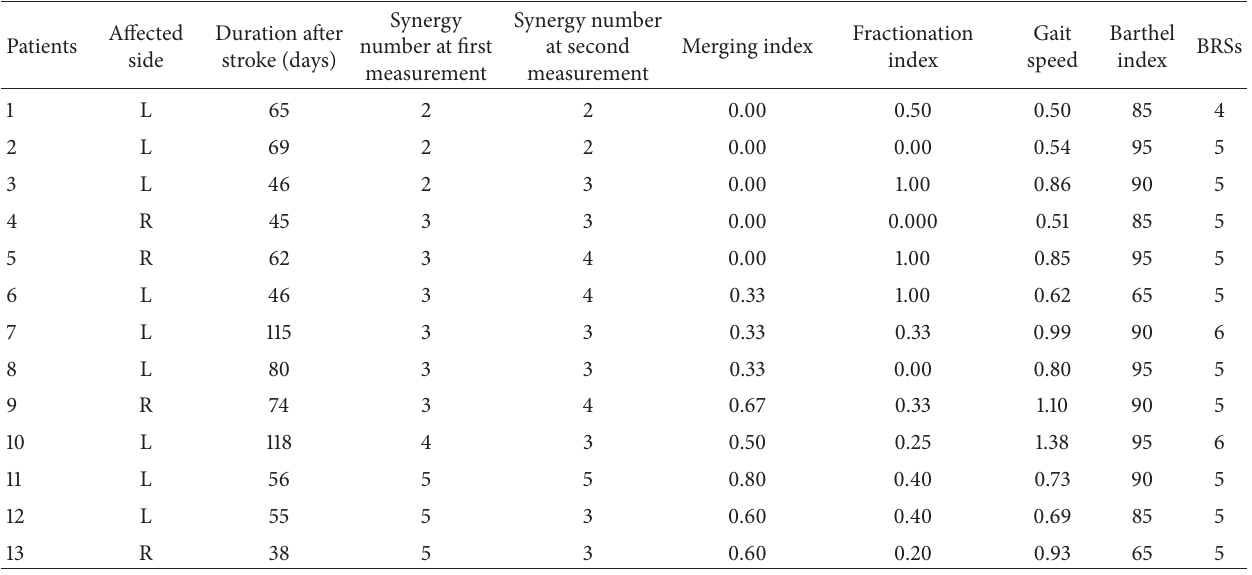
Table 3: Affected side, synergy information, and clinical status.